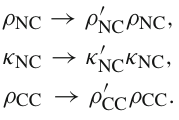
Fig. 1 Size of the purely weak one-loop corrections for the e + p unpo- larised inclusive NC DIS (left) and CC DIS (right) cross sections at selected values of Q 2 as a function of x . QED corrections due to real and virtual photons and corrections from the vacuum polarisation (the